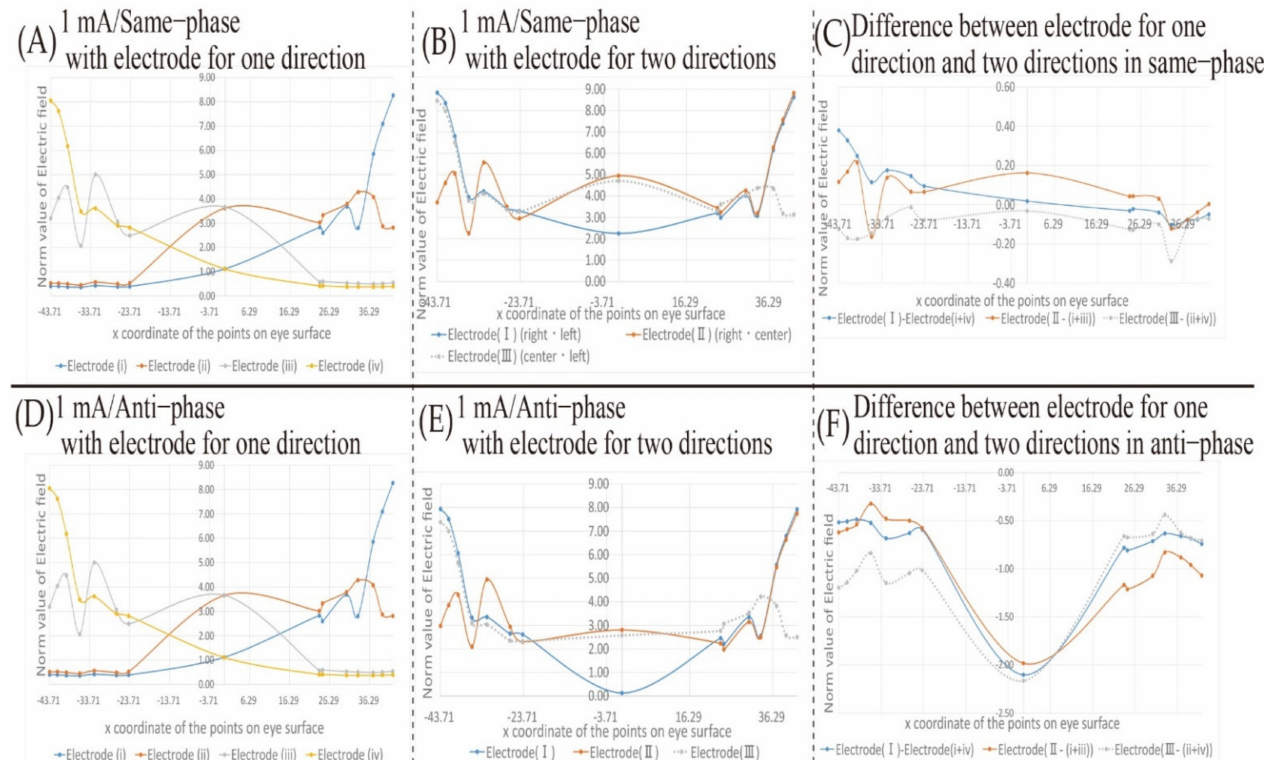
Figure 9. The transition of the electric field value on the eye surface with the electrode placement that stimulates the intended region on the eyeball surface in 1 mA; ( A ) norm value of electric field in 1 mA and same-phase stimulus with electrode to present phosphene in one direction; ( B ) norm value of electric field in 1 mA and same-phase stimulus with electrode to present phosphene in two directions; ( C ) difference of norm value of electric field in 1 mA and same-phase stimulus between electrode to present phosphene in one direction and electrode to present phosphene in two directions; ( D ) norm value of electric field in 1 mA and anti-phase stimulus with electrode to present phosphene in one direction; ( E ) norm value of electric field in 1 mA and anti-phase stimulus with electrode to present phosphene in two directions; ( F ) difference of norm value of electric field in 1 mA and anti-phase stimulus between electrode to present phosphene in one direction and electrode to present phosphene in two